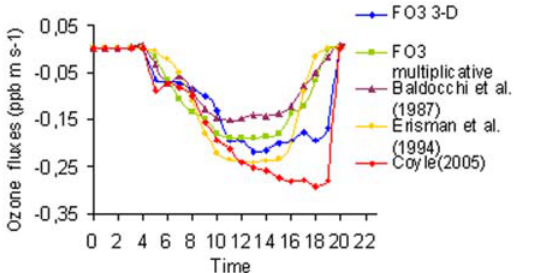
FIGURE 4. FO 3 for anthesis at 2002. Authors references indicate the resistance-type model used. Data compared are 1-h average values taken from 10-min average